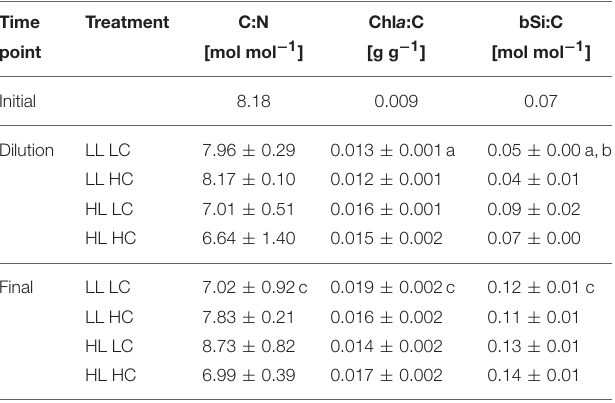
TABLE 1 | Elemental composition of phytoplankton assemblages in terms of C:N, Chl a :C and bSi:C ratios before the dilution and at the end of the experiment ( n = 3; mean ± 1 s.d.).